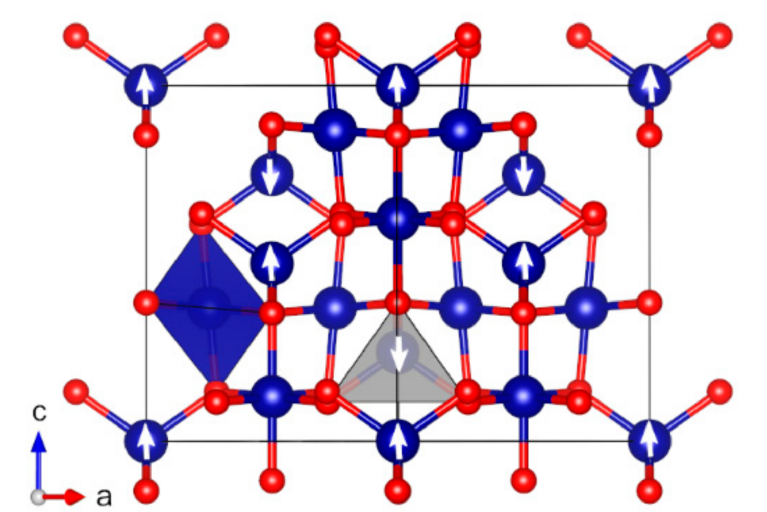
Figure 7. Optimized structure of Co 3 O 4 ( cF 56) (red: O, dark blue: Co). The directions of magnetic moments are illustrated by white arrows. Coordination octahedra and tetrahedra of Co atoms are shown in dark-blue and light-grey colors,